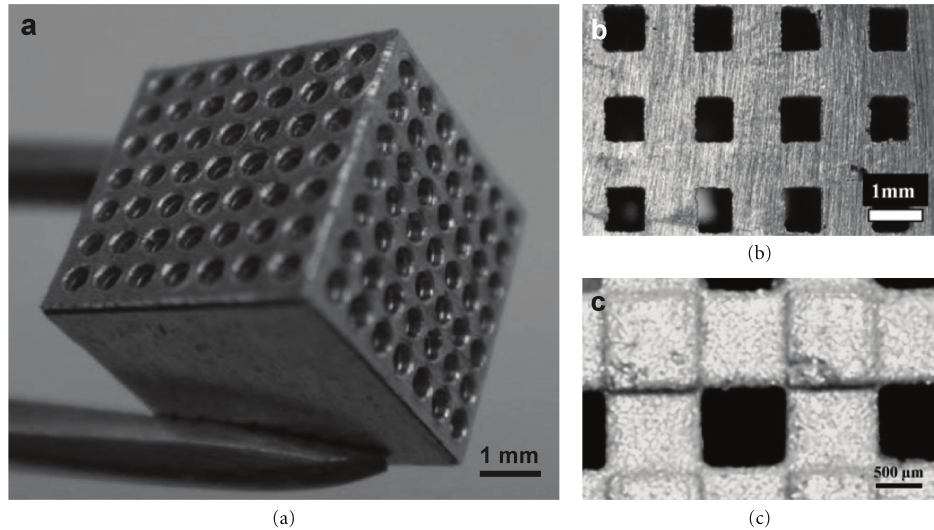
Figure 2: Example of porous Mg sca ff olds: (a) made by laser-assisted mechanical perforation technique, adapted with permission from IOP [50]; (b, c) made by solid free-form fabrication method, adapted with permission from John Wiley and Sons